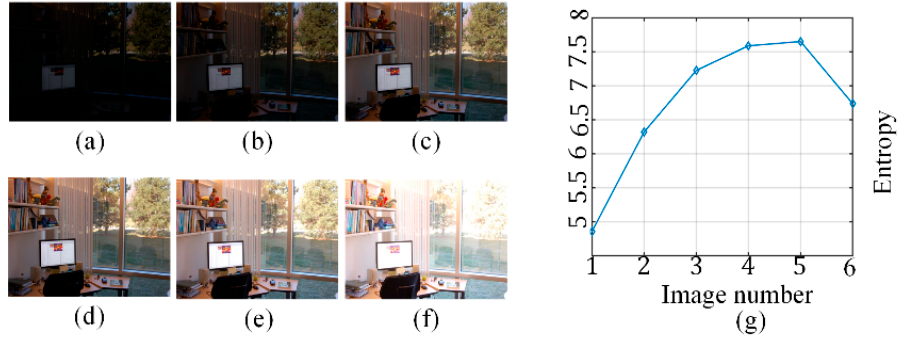
Figure 5. Comparison of the entropy among different images. ( a – f ) Images with different luminance values. ( g ) Entropy comparison.